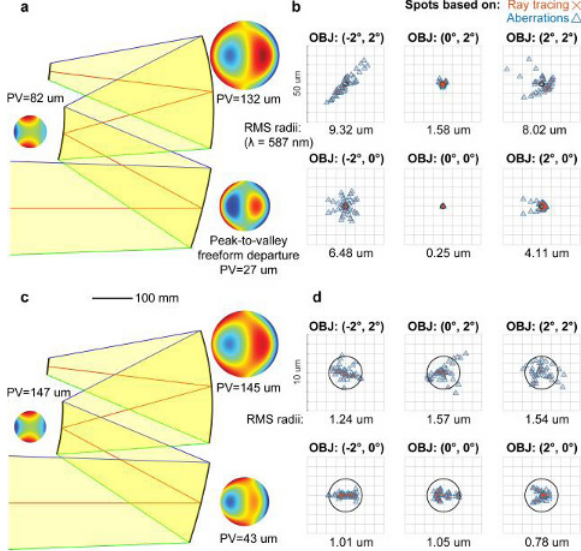
Fig. 2. "First time right" results for the three-mirror imager: a Cross-section of the directly calculated system. b Spot diagram for six fields based on aberration calculations and ray tracing in comparison. c Cross-section of the further optimized system. d Spot diagram for the identical six